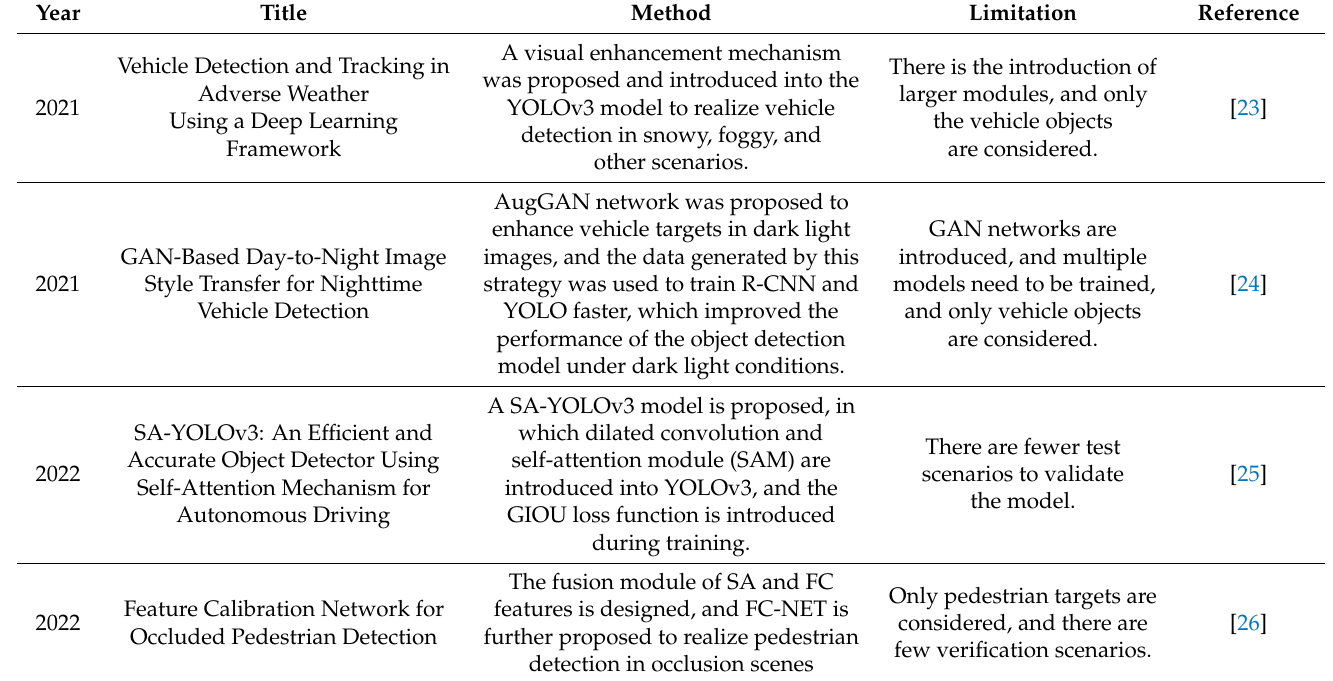
Table 1. Summary of literature survey on vehicle view object detection